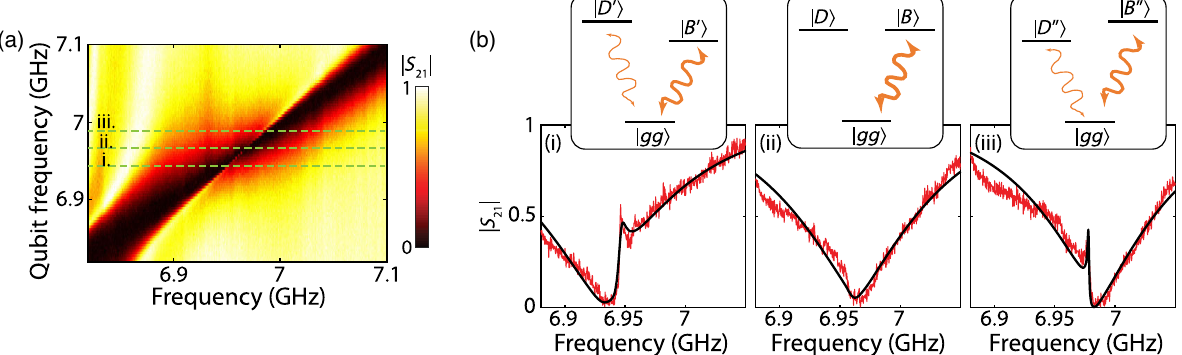
FIG. 14. (a) Enlarged view of the swirl feature near 6.95 GHz of the experimental data illustrated in Fig. 3(c) in the main text. (b) Transmission spectrum across two-qubit resonance for three different frequency tunings, corresponding to line cuts marked with green dashed lines on (a). The insets in (b) show the corresponding level diagram with j gg i denoting both qubits in ground states and j B i ( j D i ) representing the perfect bright (dark) state. The state notation with prime [double prime] in (i) [(iii)] denotes the imperfect superradiant bright state and subradiant dark state, with the width of orange arrows specifying the strength of the coupling of states to the waveguide channel. Panel (ii) occurs at the center of the swirl, where perfect superradiance and subradiance takes place (i.e., bright state waveguide coupling is maximum and dark state waveguide coupling is zero). The black and red curves correspond to experimental data and theoretical fit,